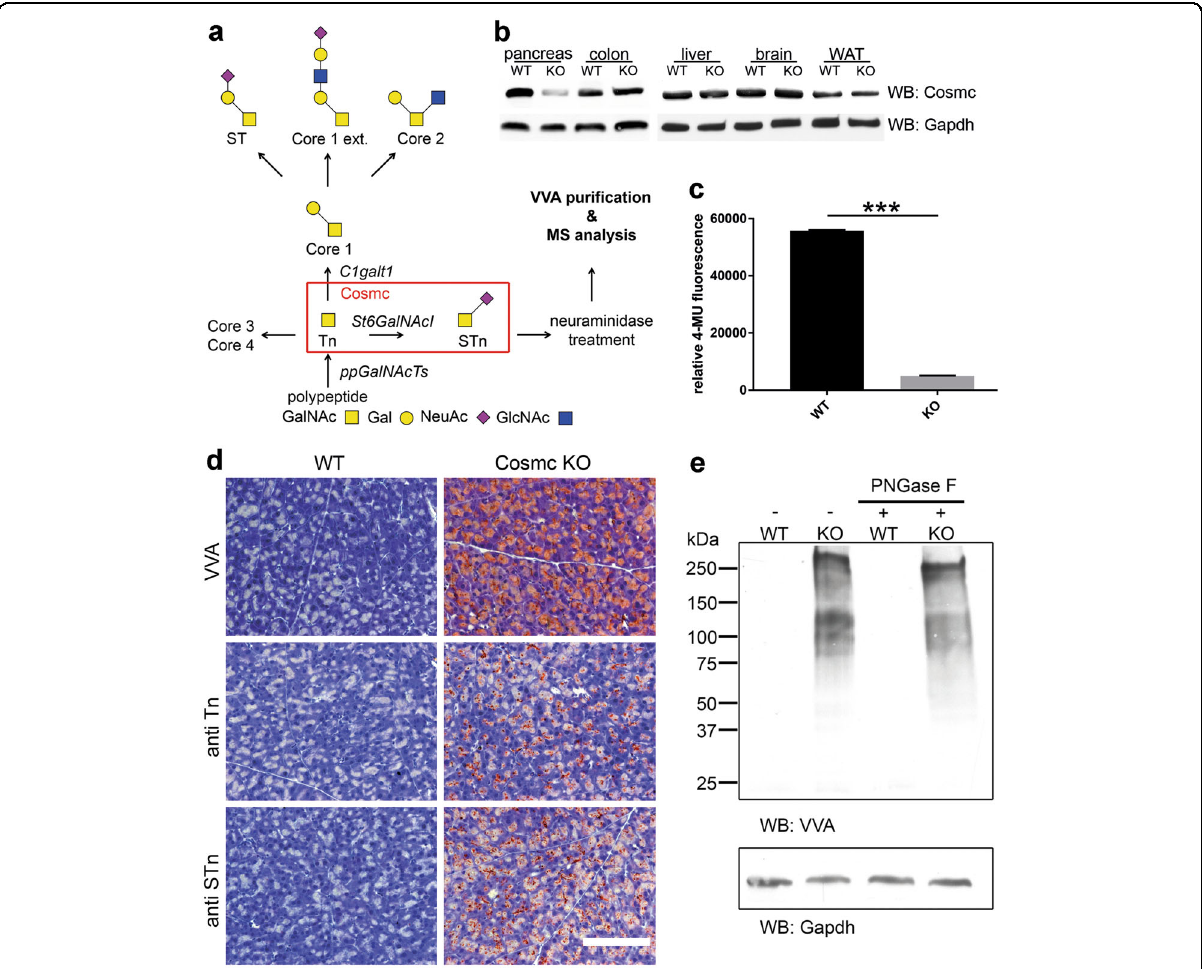
Fig. 1 Deletion of Cosmc results in loss of core 1 glycan formation. a Scheme of O-glycosylation pinpointing the role of Cosmc. Depending on the biological context, a set of expressed ppGalNAcTs transfer GalNAc moieties to serine and threonine residues of the target proteins. Subsequent extension from Tn antigen to core 1 is performed by C1galt1 (T-synthase) being folded and stabilized by Cosmc. Lack of T-synthase activity results in Tn and STn expression. b Anti-Cosmc Western blot analysis of pancreas, colon, liver, brain and white adipose tissue (WAT) lysates derived from WT and pancreas-speci fi c Cosmc- KO mice. Clearly reduced Cosmc protein is observed in KO pancreatic tissue. c The fl uorescent T-synthase assay further validated reduced T-synthase activity in Cosmc- KO pancreatic tissue compared to WT ( n = 4). d Representative histochemical staining using VVA on FFPE WT and Cosmc- de fi cient mouse pancreata demonstrates speci fi c binding to acinar cells in Cosmc KO. Further, antibodies directed against Tn and STn antigens speci fi cally detected pancreatic acinar cells in Cosmc KO. The scale bar equals 50 µm. e Far-Western blot analysis of whole- pancreatic tissue lysates of Cosmc- KO mice display Tn antigen expression on a variety of proteins, whereas no reactivity is observed in lysates of WT littermates. PNGase F treatment did not alter VVA reactivity in Cosmc- KO lysates, emphasizing VVA speci fi city towards O-linked